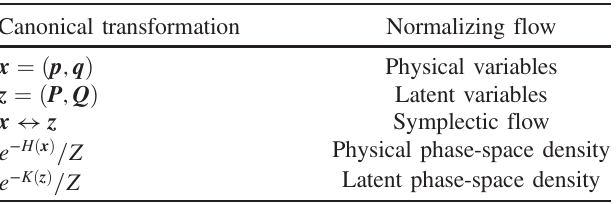
TABLE I. The correspondence of a canonical transformation and normalizing flow. See Sec. II C for explanations of the